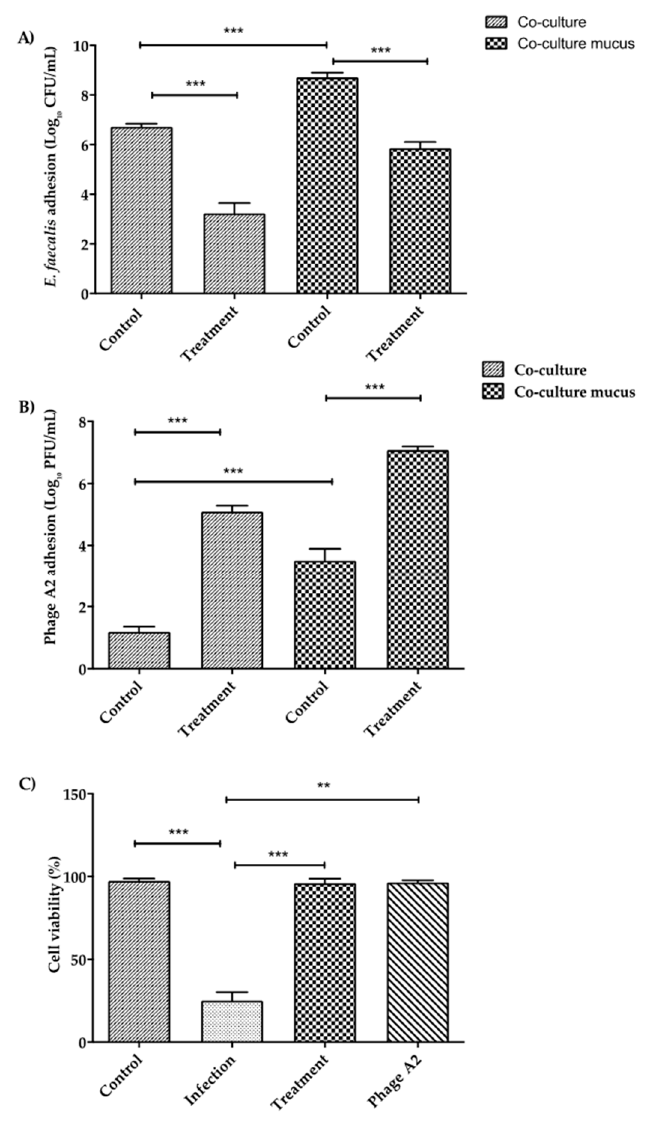
Figure 5. ( A ) Enterococcus phage A2 and adhered E. faecalis interaction in a co-culture mimicking the intestinal epithelium with and without mucus. E. faecalis was left to adhere to the co-cultures for 3 h. At this point, fresh media was added and the treatment ( E. faecalis + phage A2) groups were inoculated with phage A2. ( B ) Enterococcus phage A2 adherence to a co-culture with and without the presence of mucus. Control groups were co-cultures only inoculated with phage. The treatment groups were infected with E. faecalis for 3 h and then treated with phage. All the samples were collected at 24 h post-inoculation. ( C ) Cell survival of co-culture producing mucus following 24 h. of exposure to E. faecalis and Enterococcus phage A2. Cell survival following each exposure is shown in comparison to a control co-culture without bacteria and phage. All values are average concentrations ( n = 9) ± standard error. ** p < 0.01; *** p < 0.001.